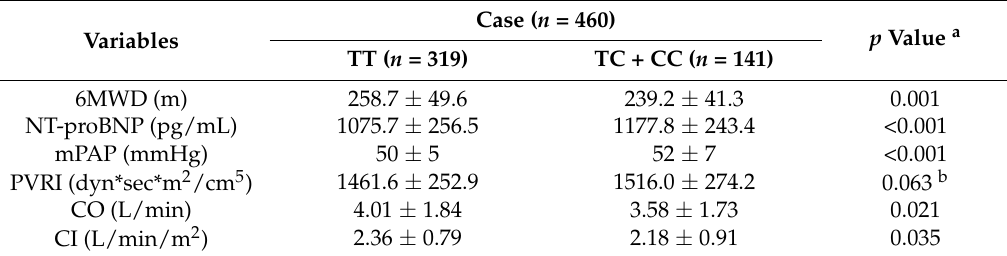
Table 3. Stratified analyses of SOD2 rs4880 polymorphism associated with the PAH clinical features by genetic dominant model.